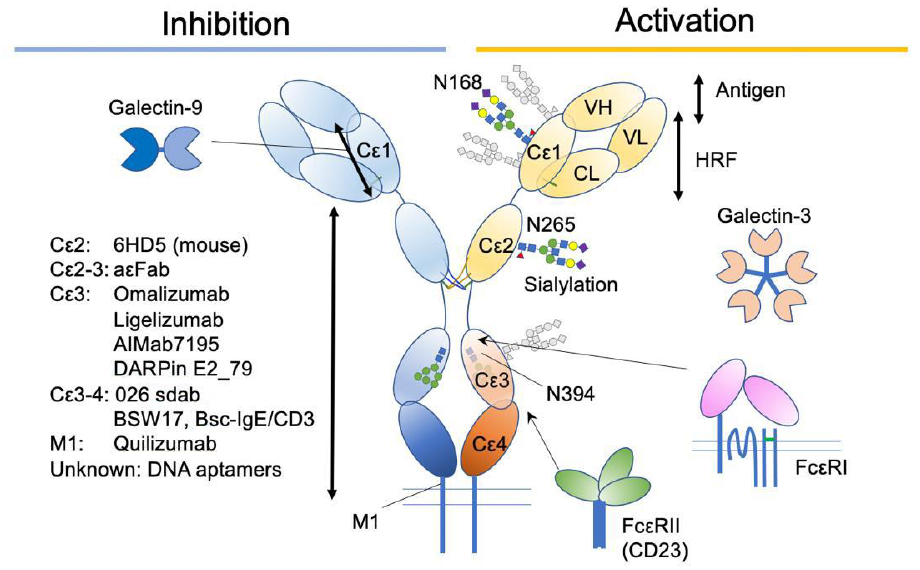
Figure 5. A summary of IgE-associating molecules and their binding sites. Omalizumab is a recombinant humanized IgG1 κ monoclonal antibody that specifically binds the C ε 3 domain of human IgE. Omalizumab specifically binds free IgE (not bound to Fc ε RI) and blocks its binding to both Fc ε RI or CD23 receptors. Since it does not affect the Fc ε RI-bound IgEs, the reduction of IgE on mast cells takes longer (~70 days) than that on basophils (~7 days), depending on their half-lives [90,91]. The initial design of omalizumab was to bind the same site of IgE as Fc ε RI does, thereby preventing anaphylaxis caused by crosslinking the Fc ε RI-bound IgE. However, X-ray crystallographic studies have shown a slightly different view of the